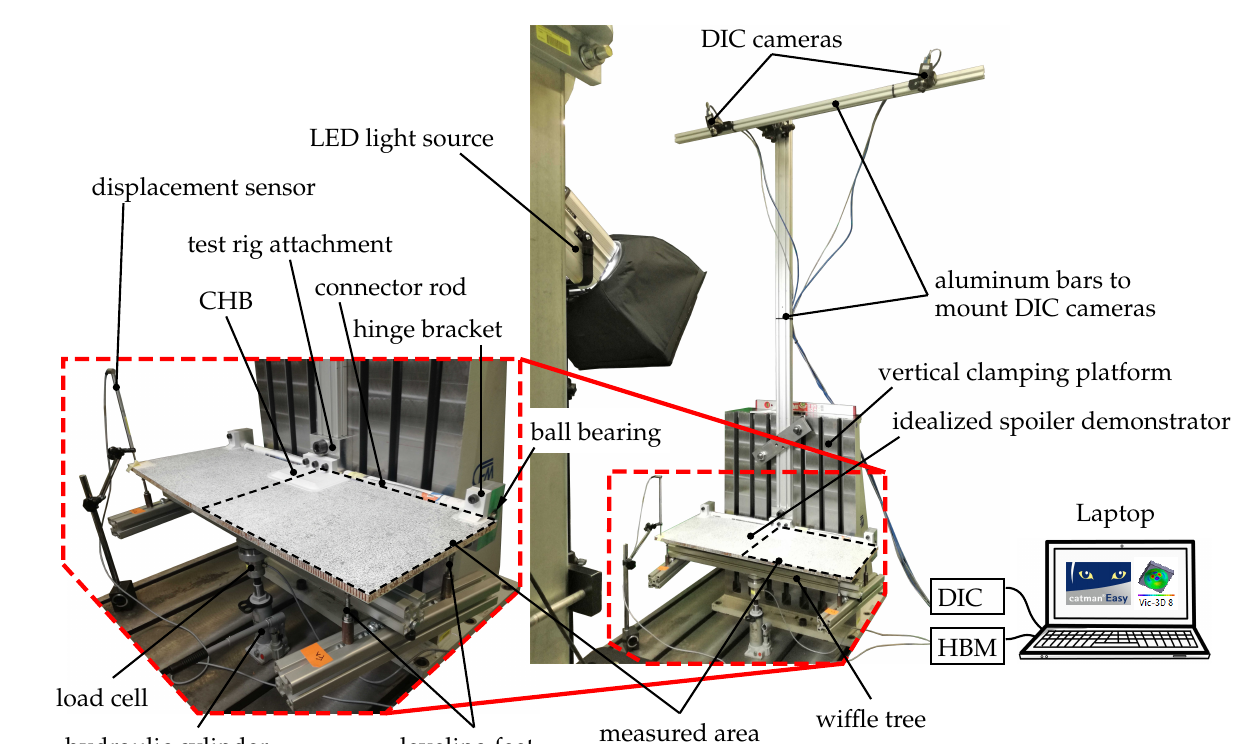
Figure 9. Test setup for the deformation and strain